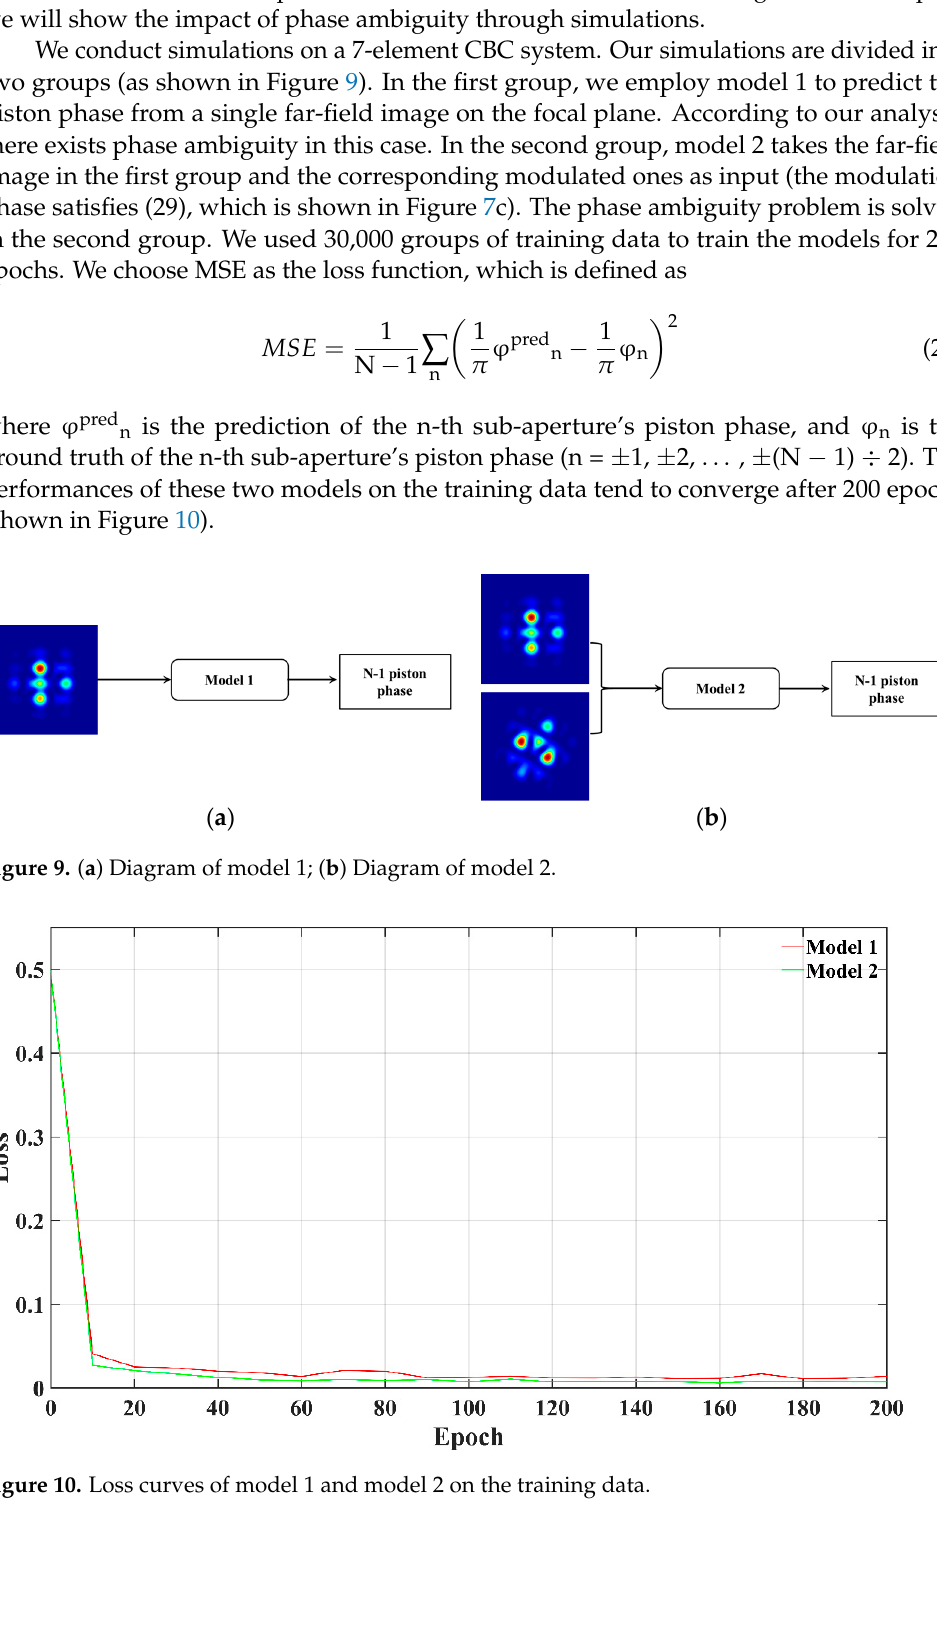
Figure 10. Loss curves of model 1 and model 2 on the training data. We take 5000 groups of testing data to test the performance of model 1 and model 2. We use the normalized power-in-the-bucket (PIB) as evaluation index, which can be ex- pressed as